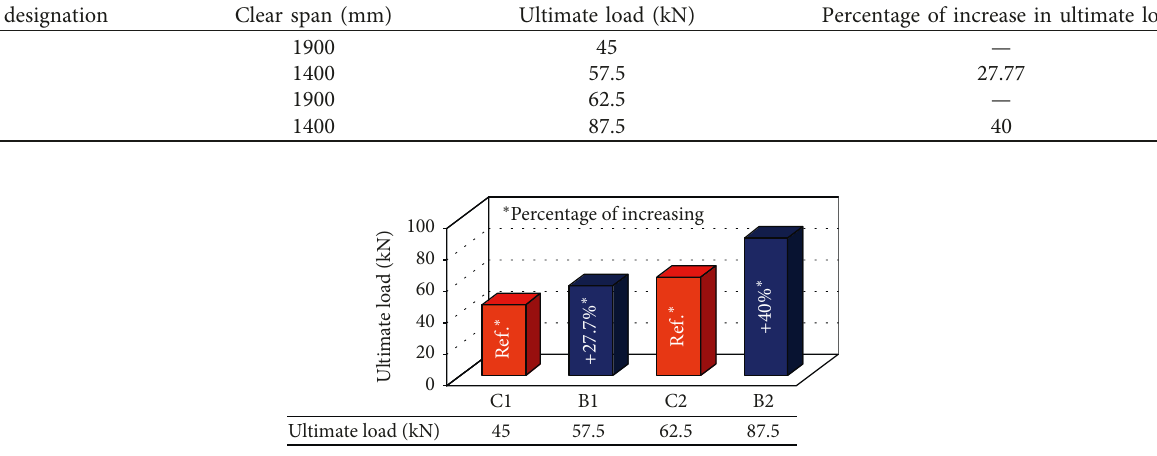
Figure 14: Effect of clear span length on ultimate load with and without carbon fiber strengthening.